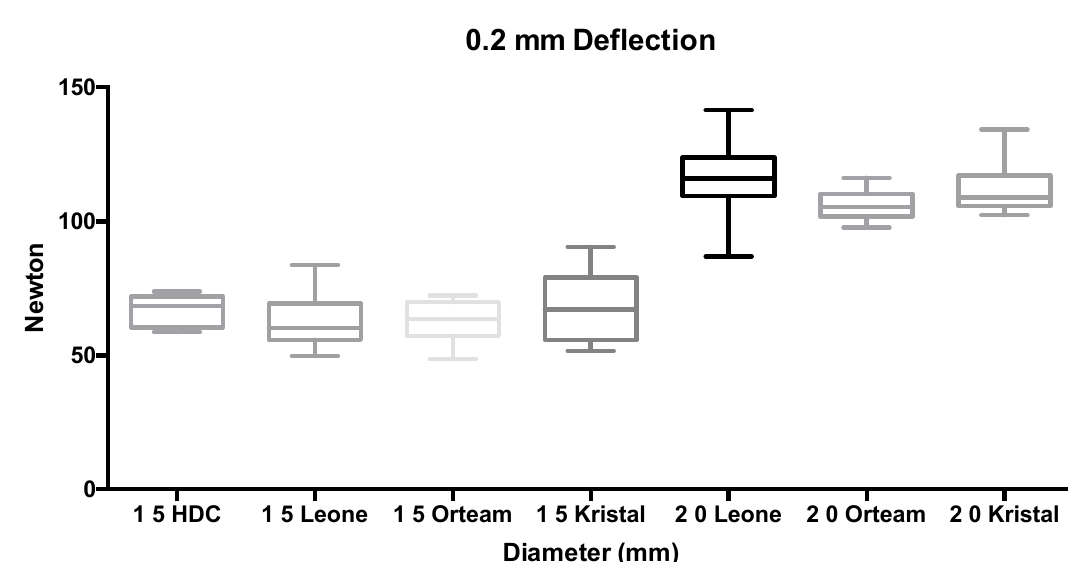
Figure 4. Box plot of groups tested at 0.2-mm deflection (N).